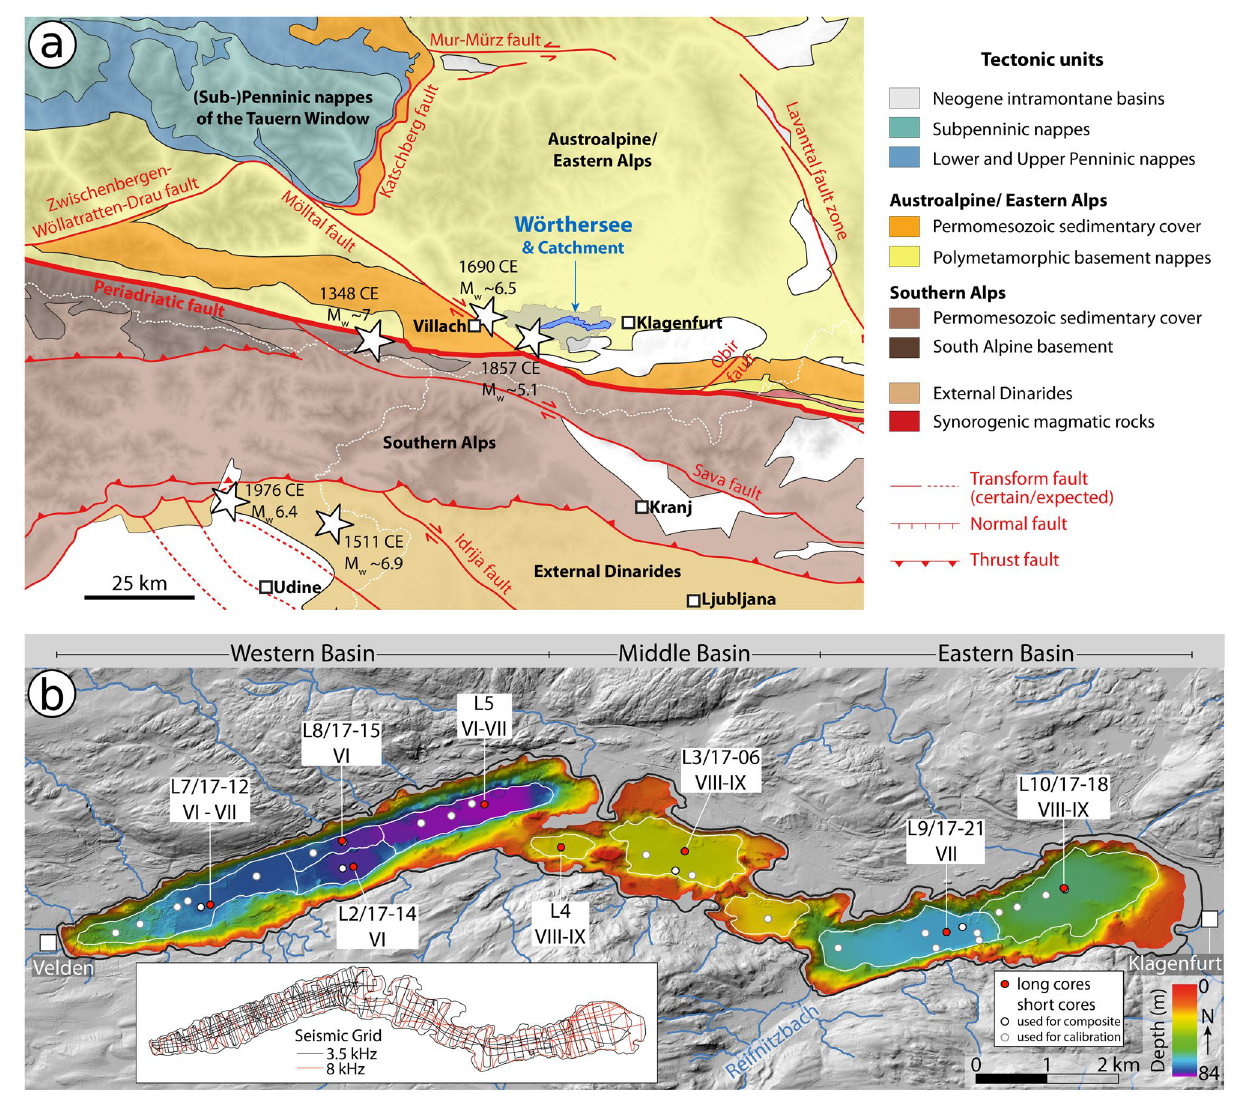
Figure 2. Overview of the study area. ( a ) Seismotectonic setting (simplified from Reinecker and Lenhardt 73 , Reiter et al. 74 , and Schmid et al. 71 ) . Earthquake epicentres and magnitudes were compiled from SHEEC 1000- 1899 32 , SHEEC 1900-2006 31 and the Austrian earthquake catalogue 34 . ( b ) Bathymetric map of Wörthersee. Coring locations are indicated as red (long Kullenberg cores) and white (short percussion cores) dots. Each coring location has a specific intensity threshold for recording earthquakes, given in roman numerals 20 . Different depositional areas are outlined in white (simplified after 20 ). In the lower left, the acquired reflection seismic grid using two different seismic sources is shown. The maps were generated using QGIS software (version 3.20.2; http:// www. qgis. microplate (so-called South Alpine indenter) into the European plate, separated at the surface by the Periadriatic fault (PAF); (2) uplift in the Eastern Alps and (3) eastward extrusion of the Pannonian fragment 27,28 (Fig. 1a, b). This geodynamic setting is reflected by back-thrusting in the southern Alps and strike-slip faults in the Eastern Alps and the Dinarides (Figs. 1b, 2a). Carinthia is among the regions with the highest seismic hazard in Austria (Fig. 1b) due to its position close to the highly seismically active areas of Friuli and western Slovenia, seismicity along the Katschberg-, Mölltal- and Periadriatic fault as well as diffuse seismicity 29 . Historical and instrumental seismicity data attest that the area of Wörthersee has experienced at least five earthquakes of local intensities (I L ) > V on the European Macroseismic scale (EMS-98 30 ) over the last ~ 800 years 31,32 : in 1976 (M w 6.4; I L V–V½), 1857 (M w ~ 5.1; I L ~ V½), 1690 (M w ~ 6.5; I L VII½–VIII½), 1511 (M w ~ 6.9; I L VI¾–VII¾) and 1348 (M w ~ 7; I L VIII–IX). The latter presumably constitutes the largest documented historical earthquake in the Alps. meromictic, i.e. mixing of the water column is limited to a certain depth, but oxygen-rich bottom water has been observed in recent years 33 . Wörthersee is subdivided into three main parts (western, middle, and eastern), which